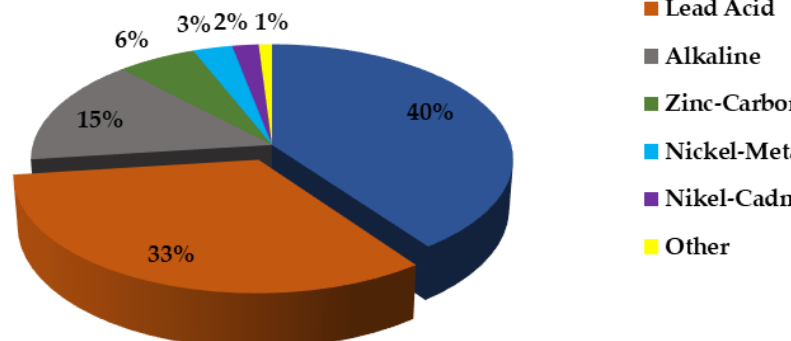
Figure 11. The income contributions made by various battery technologies globally. Figure 12 represents the life and efficiency of Pumped Hydroelectric Storage (PHS), Compressed Air Energy Storage (CAES), nickel–cadmium (Ni-Cd), lithium-ion